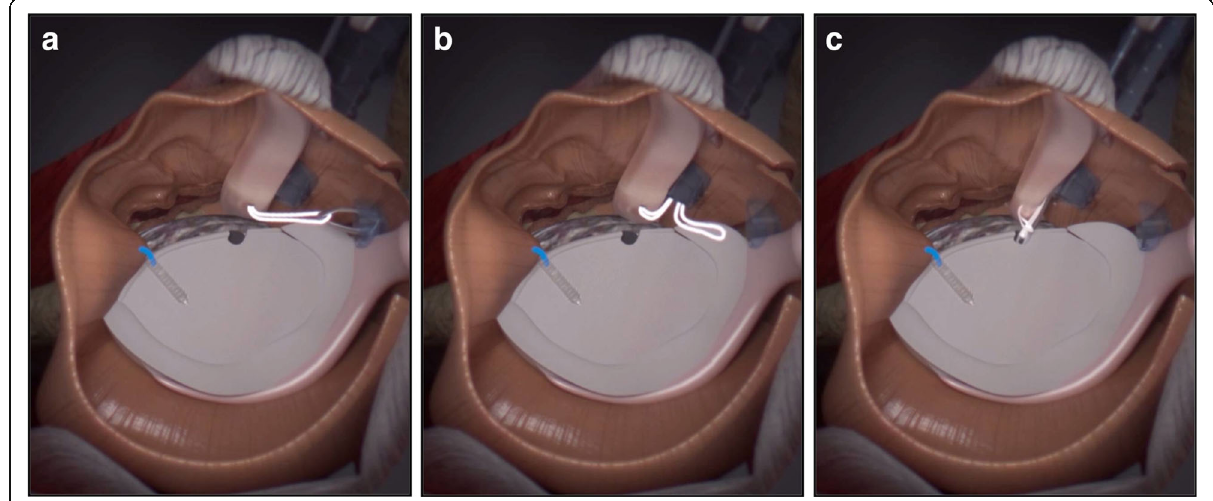
Fig. 8 The tape is carried out through the upper cannula with a suture retriever ( a ) and then passed again in the lower cannula ( b ). A loop was created, and both free ends of the tape were passed through the anchor ’ s eyelet and the anchor was pushed along the tape toward the bone hole ( c